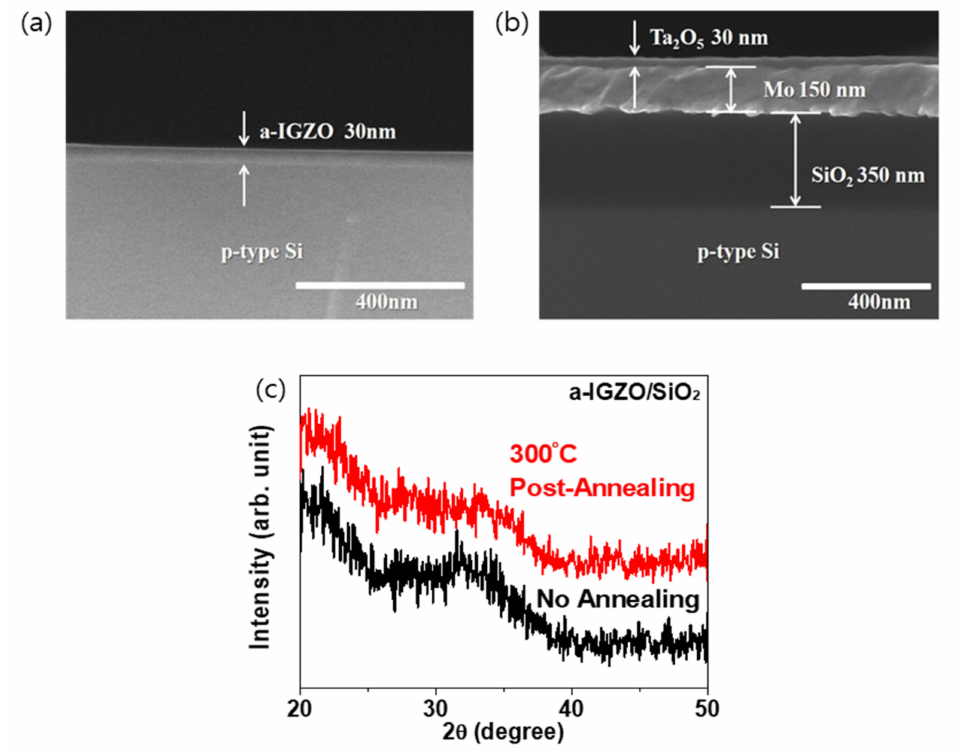
Figure 2. ( a ) The cross-sectional FE-SEM image of the a-IGZO/SiO 2 /Si structure; ( b ) the Ta 2 O 5 /Mo/SiO 2 /Si structure; and ( c ) an XRD pattern of the a-IGZO/SiO 2 layered structure grown on a Si substrate by